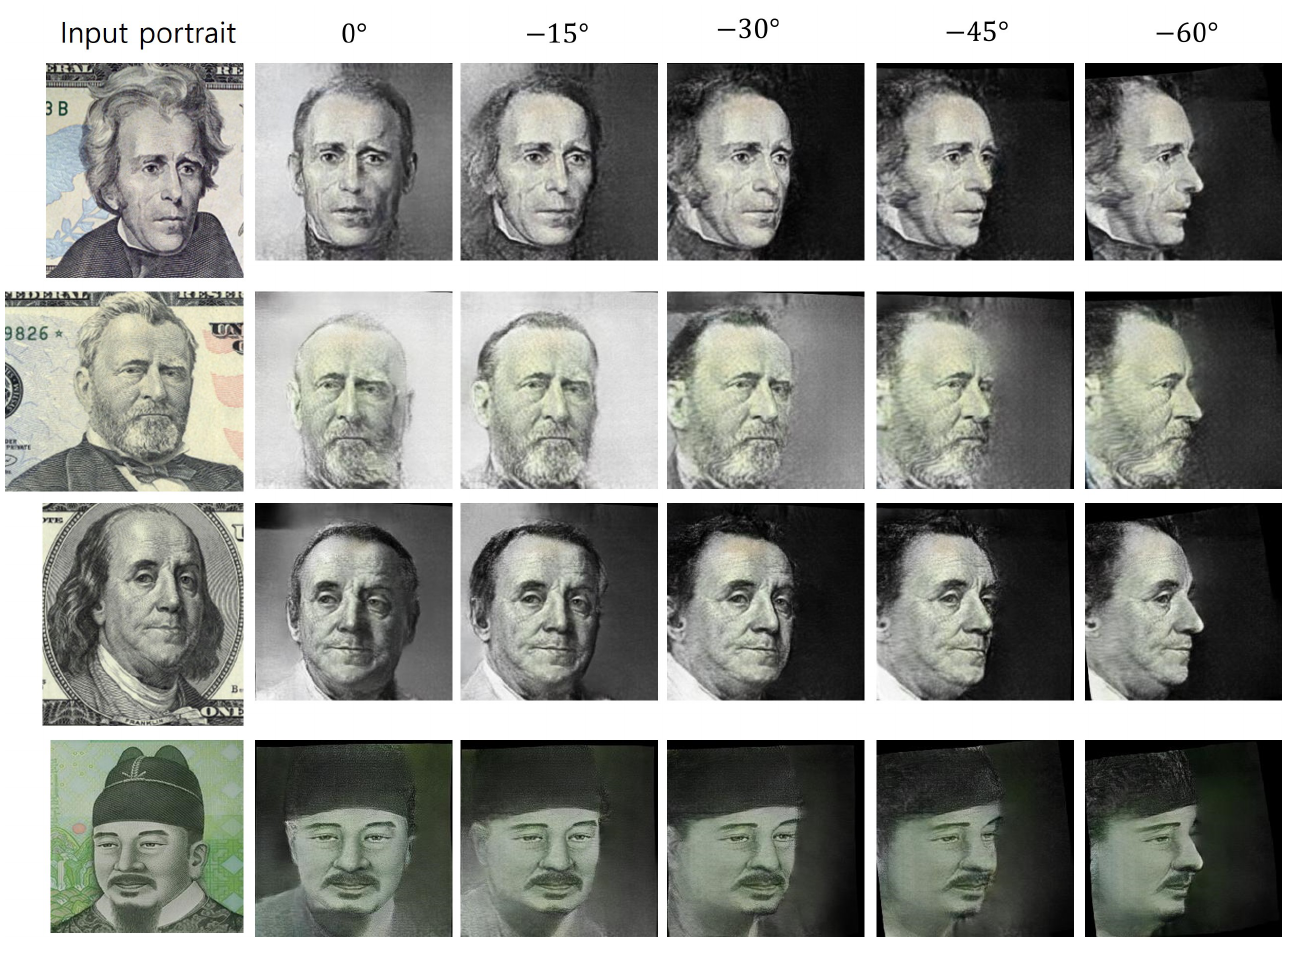
Figure 10. Portraits on banknotes.